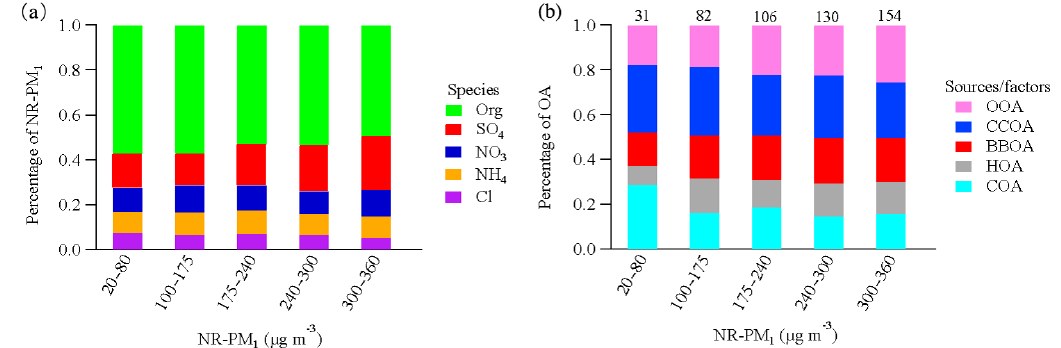
Figure 5. Relative contributions of NR-PM 1 species (a) and OA sources (b) as a function of the daily average NR-PM 1 mass concentrations. The numbers above the bars refer to the OA mass concentration (µgm − 3 ). Data collected during the Chinese Spring Festival are excluded to eliminate the influence of the change in emission patterns during the holiday.